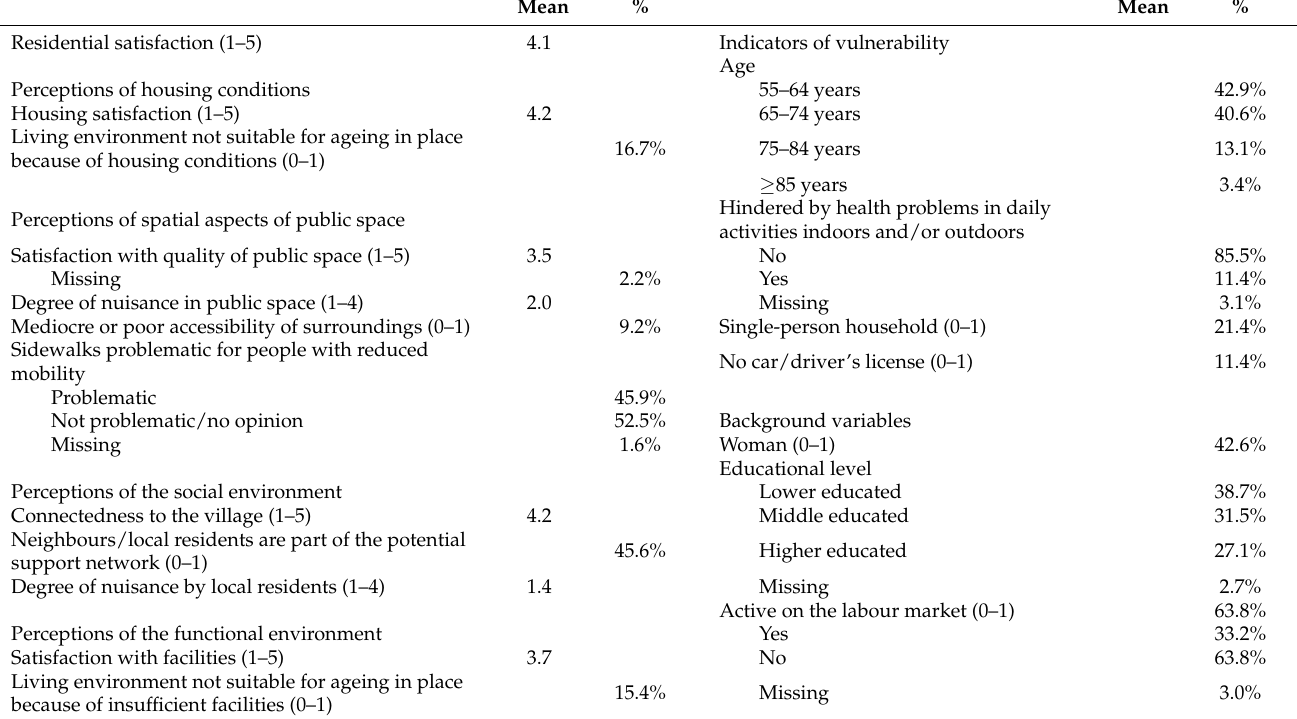
Table 3. Descriptive statistics (unweighted) of the variables included in the